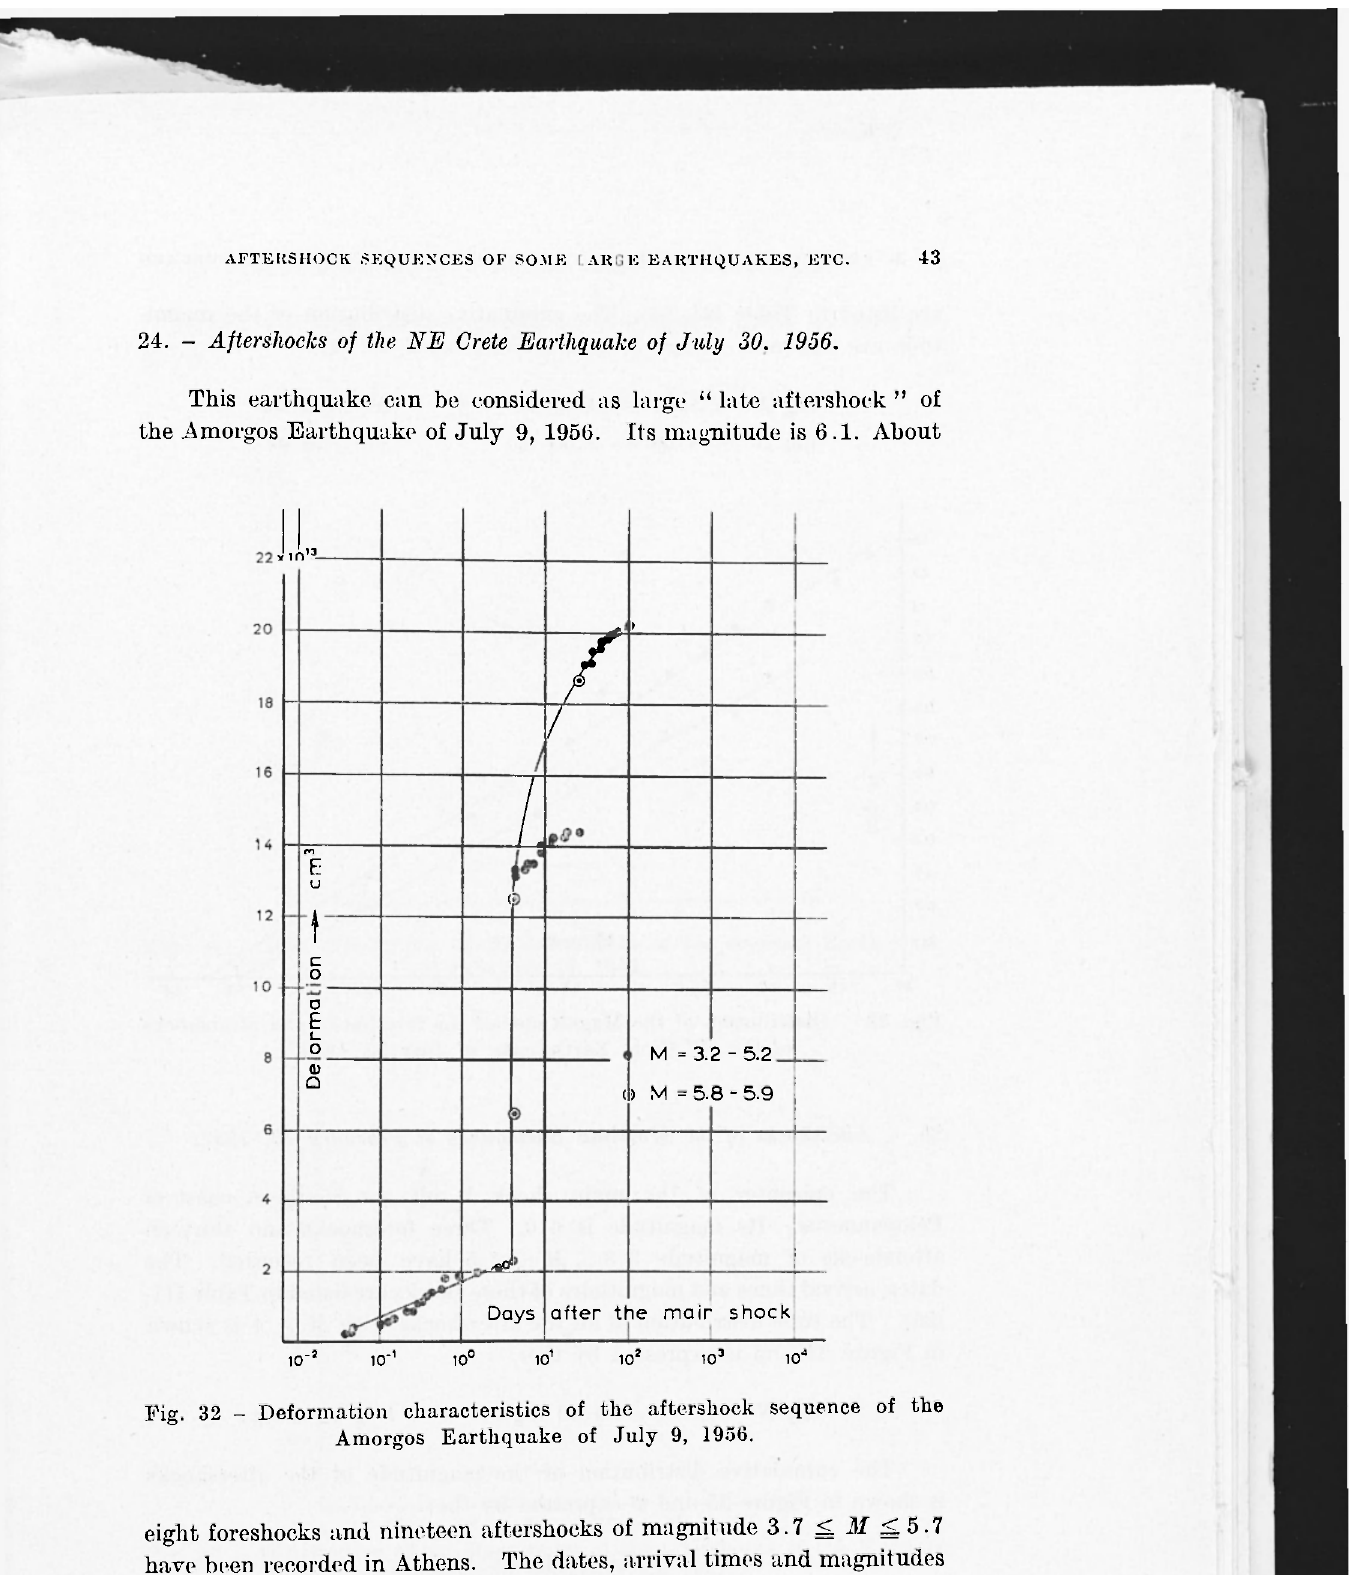
eight foreshocks and nineteen aftershocks of magnitude 3.7 ^ M g. 5.7 have been recorded in